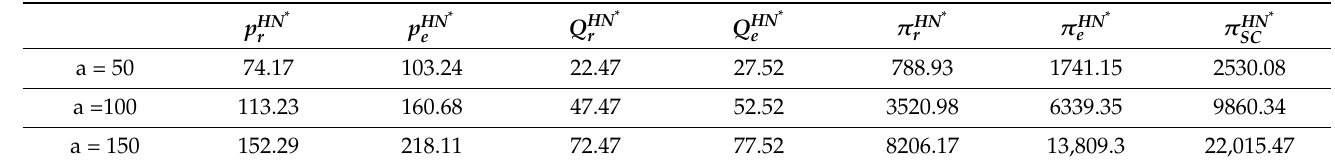
Table 4. Optimal decisions of channel members under the HN game—Case 2.